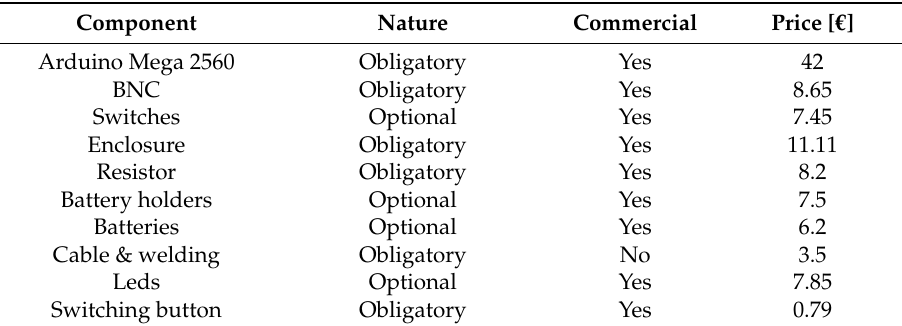
Table 3. Characteristics and price of ABDAS components.